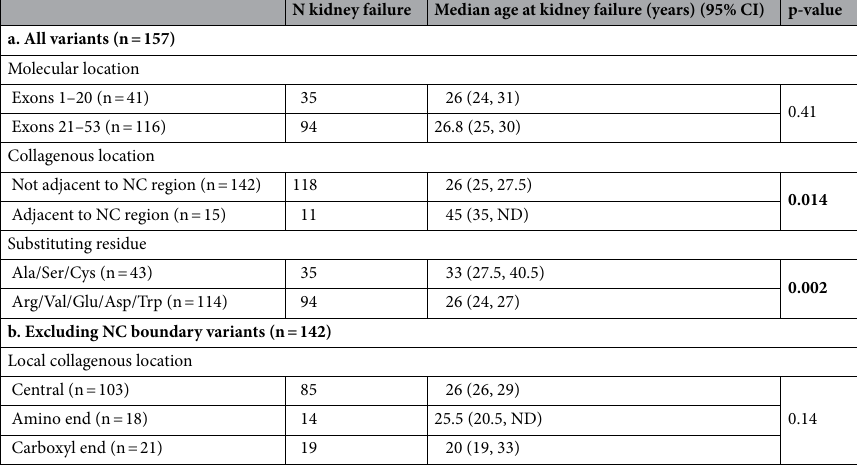
Table 1. Median age at kidney failure of COL4A5 Gly missense variants reported in LOVD for each molecular characteristic. NC, non-collagenous; ND, not done (too few data); 95% CI, 95% confidence interval. Significant values are in